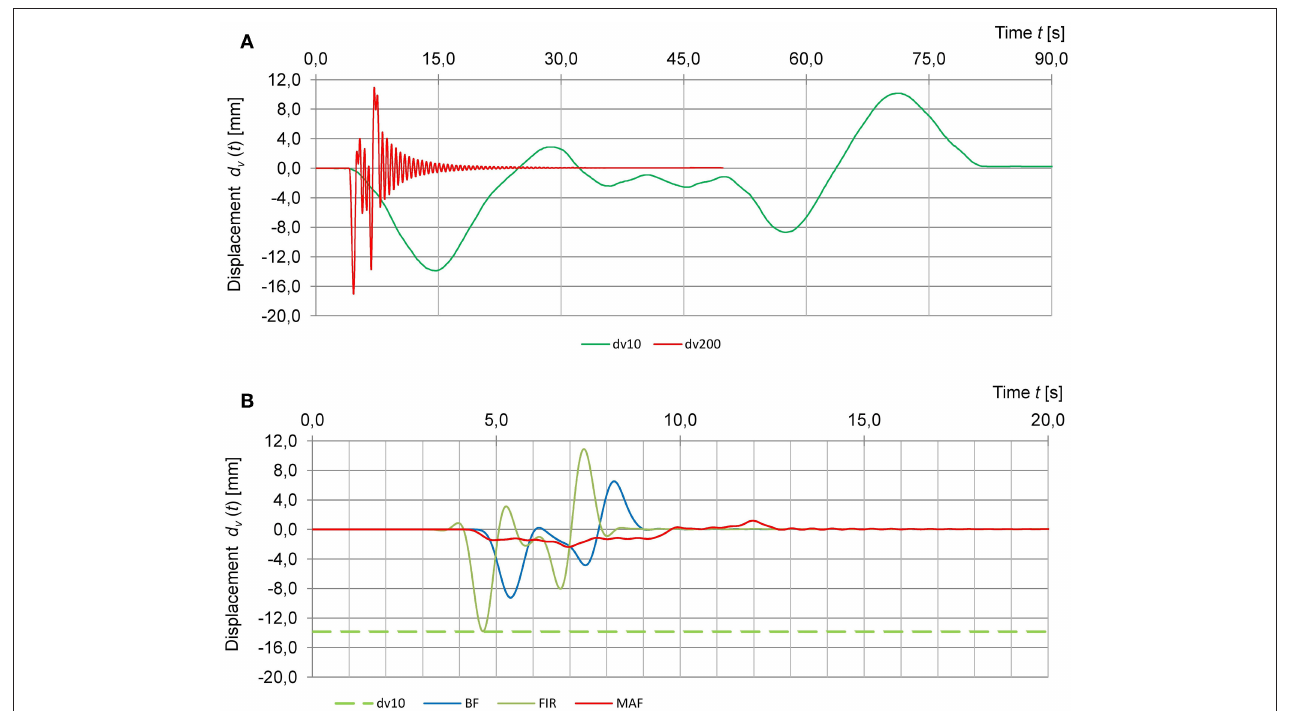
FIGURE 14 | Measured and extrapolated time-histories of the vertical displacements for train passages (the same as in Figure 13 ): (A) measured vertical displacements at the speed v = 10km/h and v = 200km/h; (B) the quasi-static value estimation using the low-pass BF, Bessel filter; FIR, FIR filter; and MAF, moving average